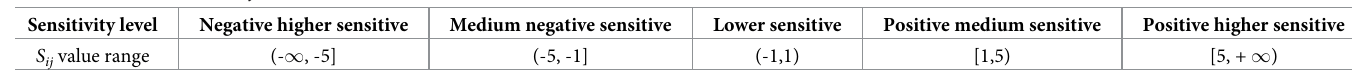
Table 3. Classification for S